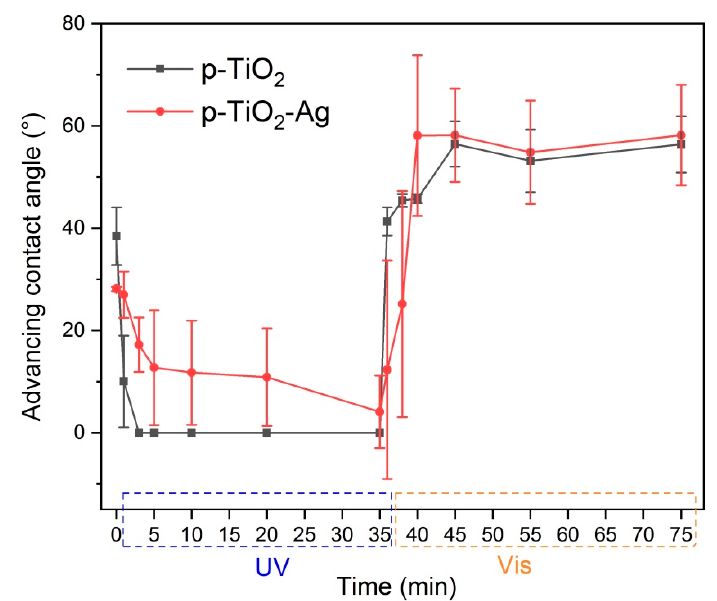
Figure 3. Photoinduced wettability conversion behavior of p-TiO 2 and p-TiO 2 –Ag samples.